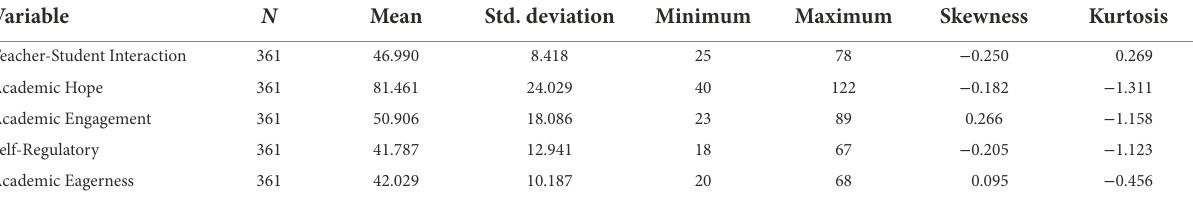
TABLE 2 Central indicators and dispersion of research variables.